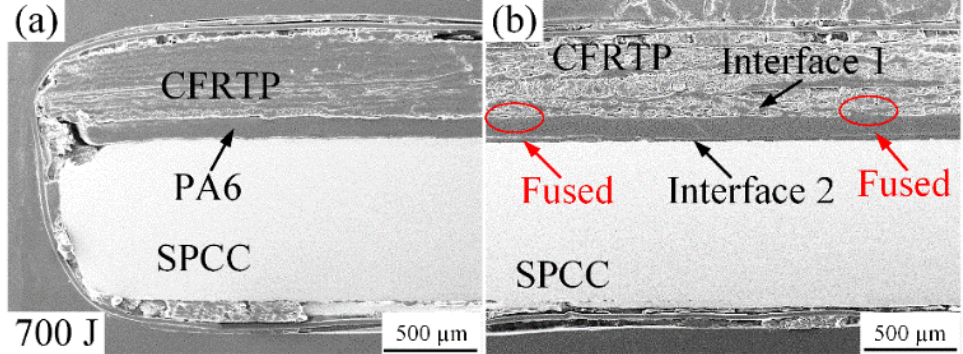
Figure 8. Microstructure of the joint cross-section at the 700 J energy: ( a ) carbon fibers squeezed out phenomenon; ( b ) situation of interface 1 and 2.